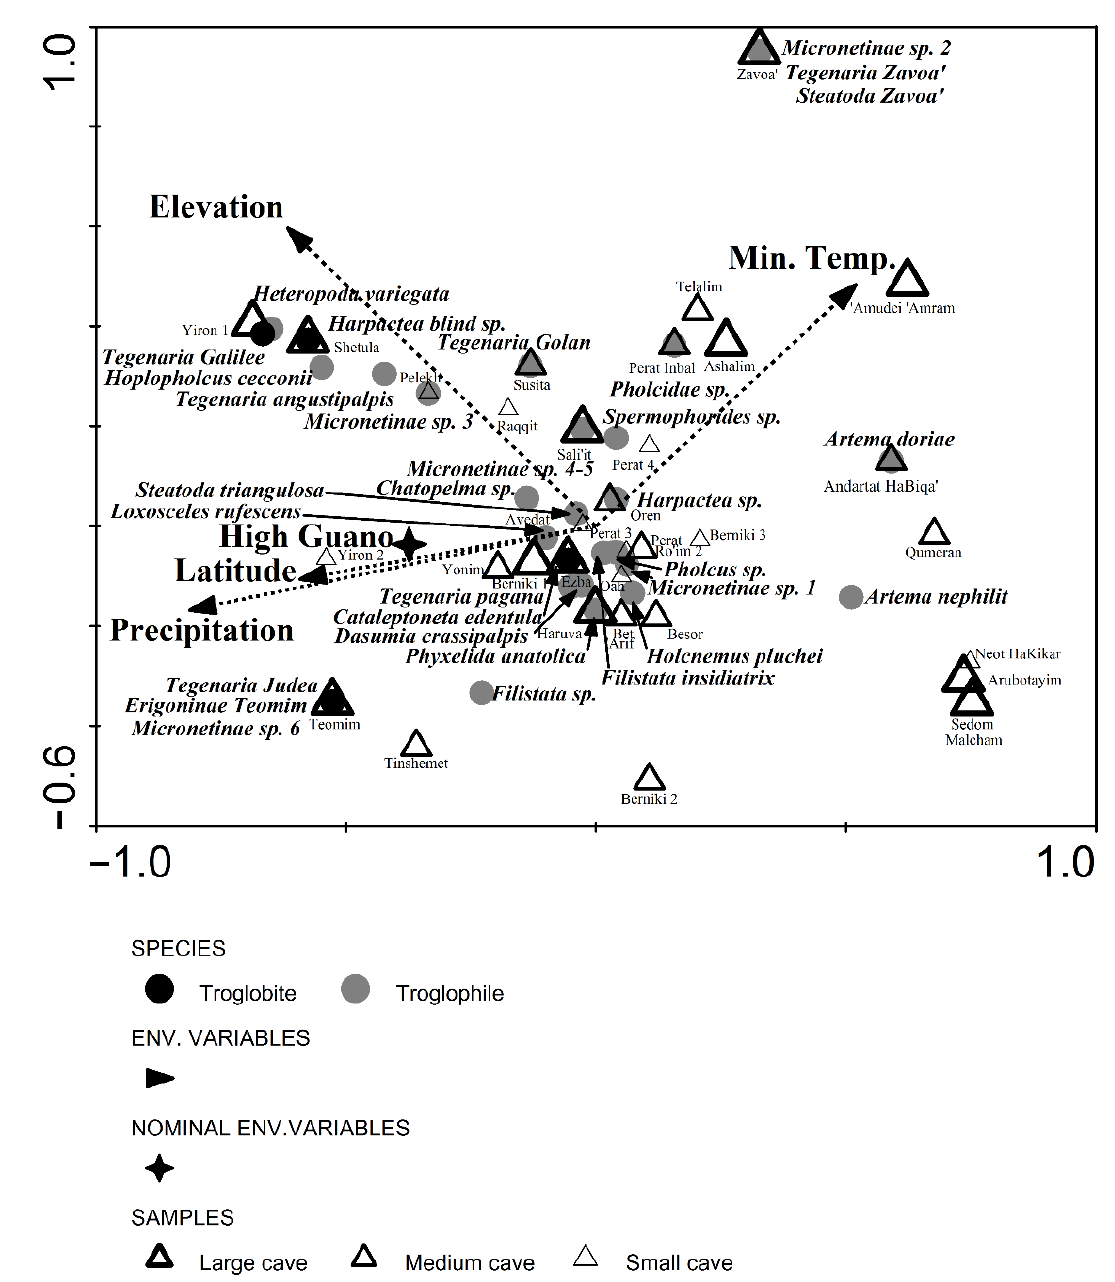
Figure 11. CCA ordination graph of the first and second axes testing 34 caves and 32 troglobite/troglophile species. The significant explanatory variables (precipitation, elevation, latitude, minimum temperature, and high guano level) are plotted on the graph, as well as the cave and species names. Cave sizes are represented by large, medium, and small triangles, respectively, troglobite species by black points, troglophile species by grey points, nominal explanatory variable by a black star, continuous explanatory variables by arrows with the dashed line. The non-dashed line arrows are used to connect between species name and its centroid.